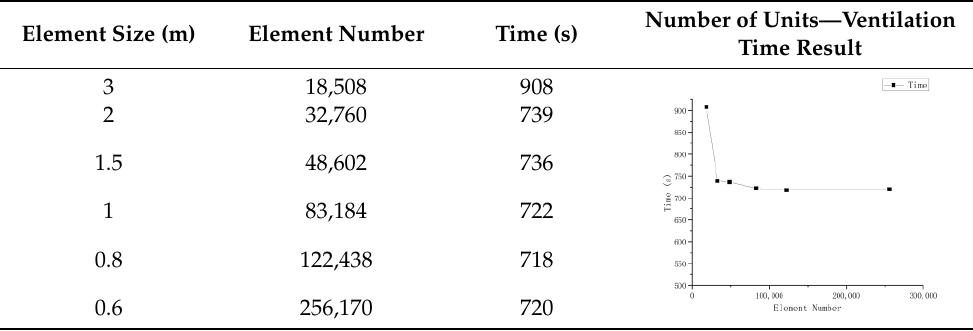
Figure 2. Model and mesh generation. Table 1. Statistical table of grid independence verification results.